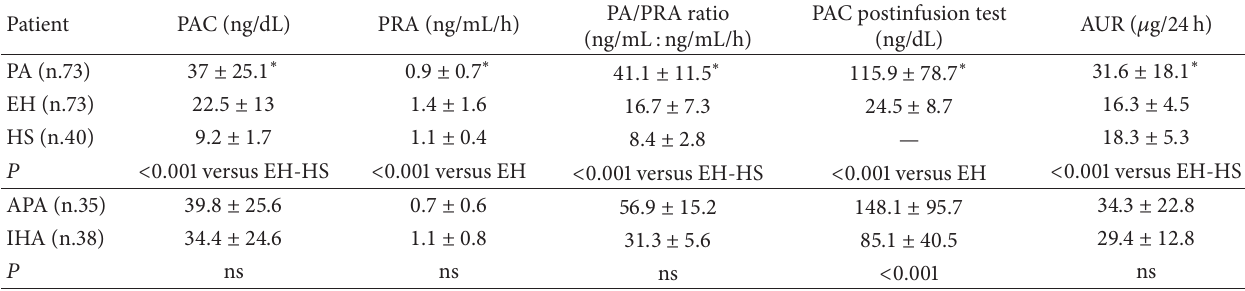
Table 3: Renin-angiotensin-aldosterone system parameters in all subjects enrolled.